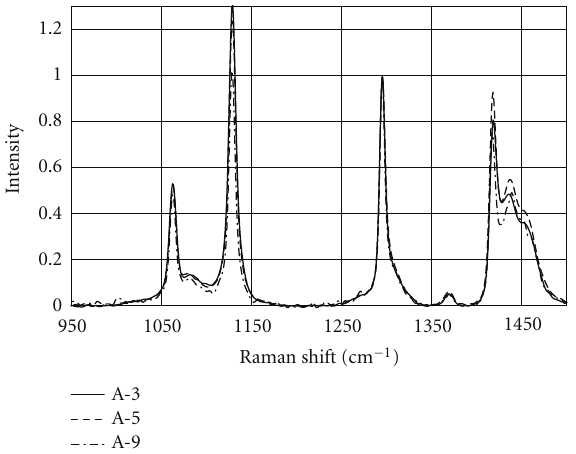
Figure 3: Raman spectra of some LLDPE monofilaments.